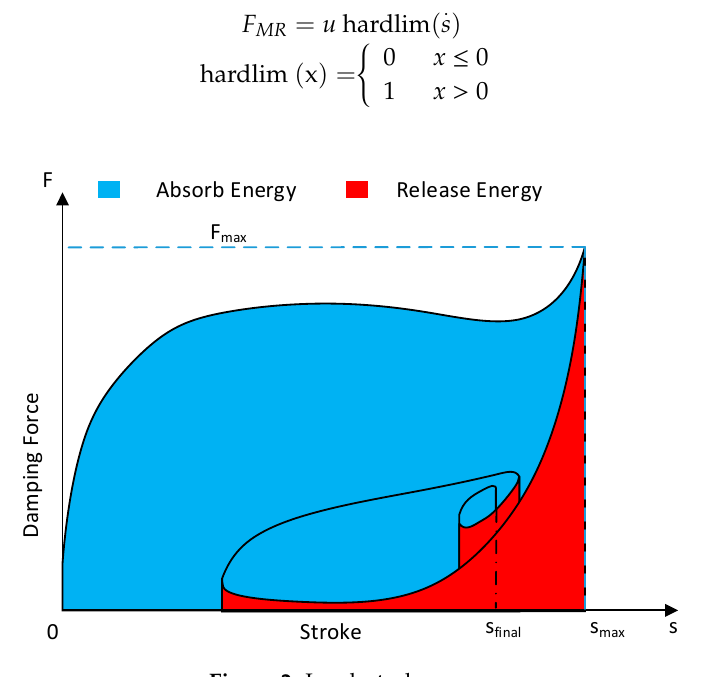
Figure 2. Load–stroke Figure 2. Load – stroke curve.